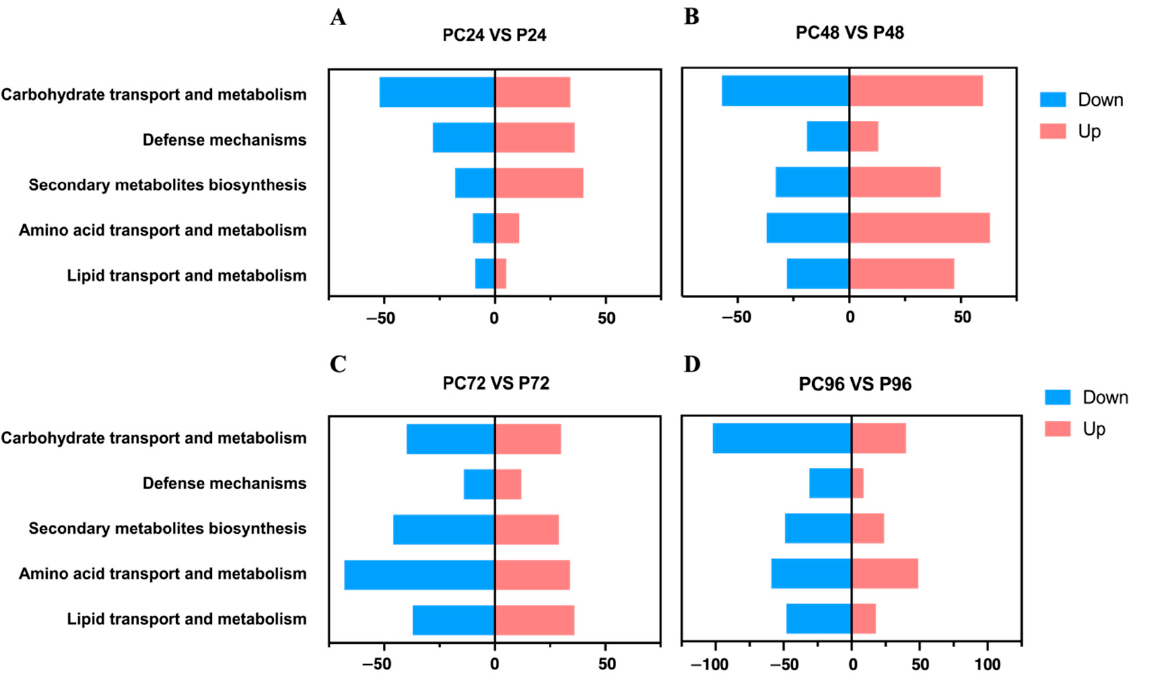
Figure 1. KEGG enrichment of differential genes for ( A ) 24 h, ( B ) 48 h, ( C ) 72 h, and ( D ) 96 h co-culturing.